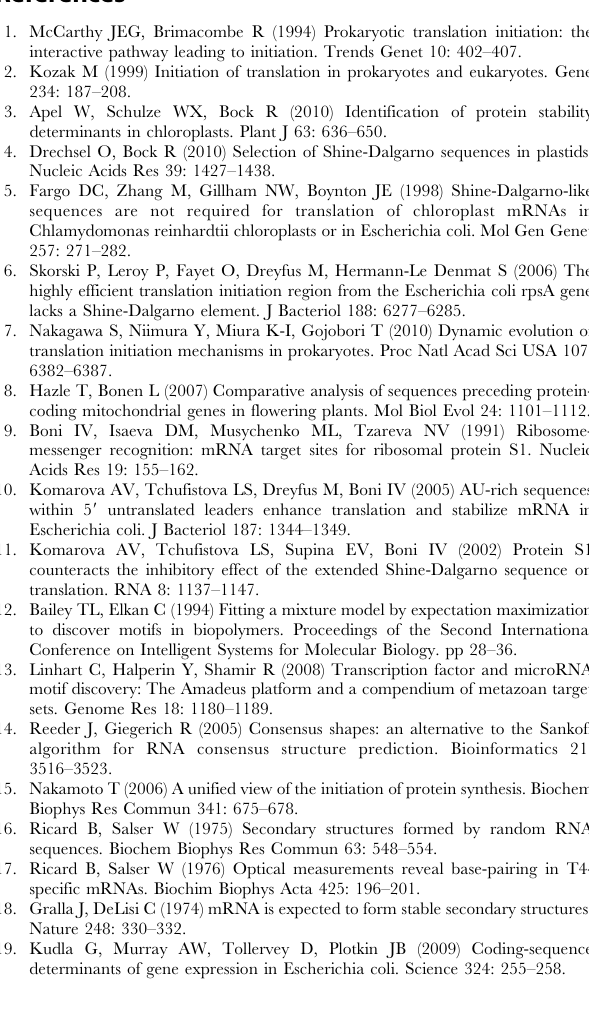
Figure S11 Correlation between LacZ activity and strength of Shine-Dalgarno-type binding between the 5 9 UTR (from position - 22 to -2) and the ASD (CCUCCU) in the 16S rRNA tail (hybridization energies given in kcal mol 2 1 ). There is a significant correlation, because there are many constructs without SD, but also an inaccessible start codon (i. e., constructs that were designed to have low translational activity). Table S1 List of oligonucleotides used in this study. Primer numbers correspond to construct